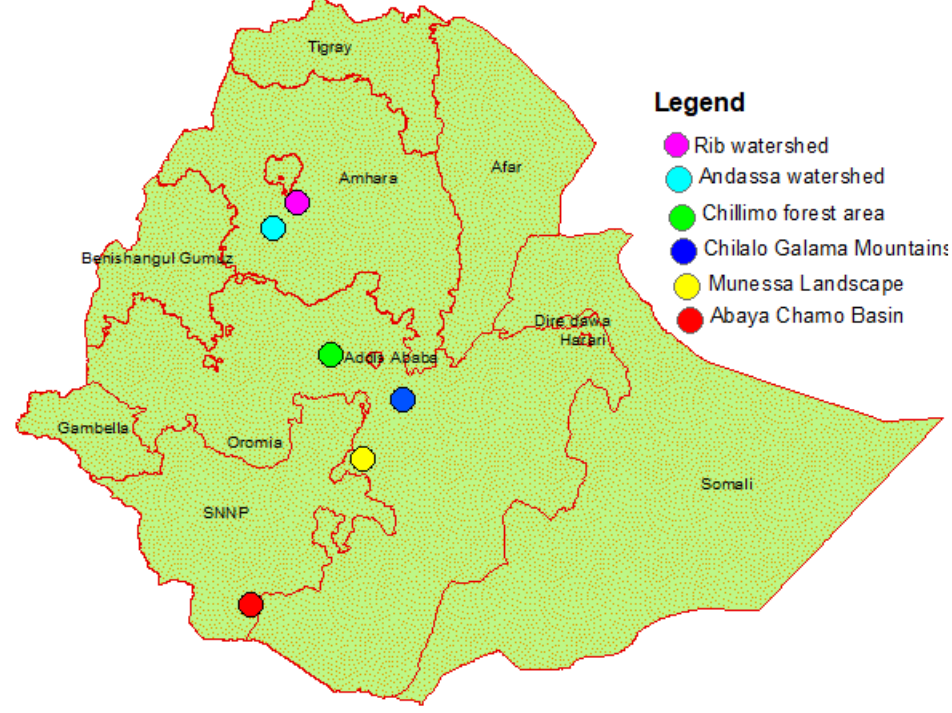
Figure 2. Map of Ethiopia showing the location of the studied areas reviewed in the study. Table 1. Spatial and temporal distribution for the mountainous locations of the selected papers .